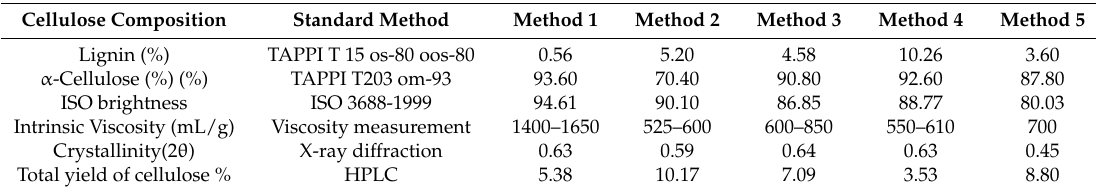
Chemical composition, physical and chemical properties of cellulose extracted by different